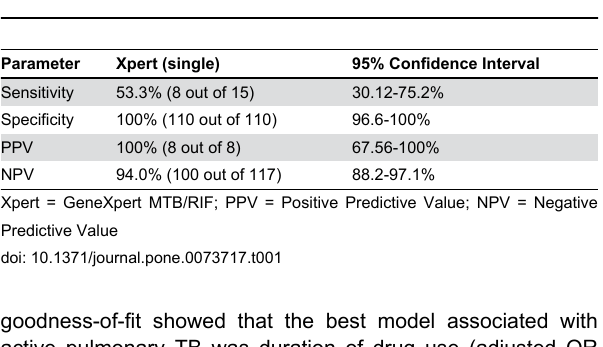
Table 1. The diagnostic accuracy of a single GeneXpert MTB/RIF assay in this